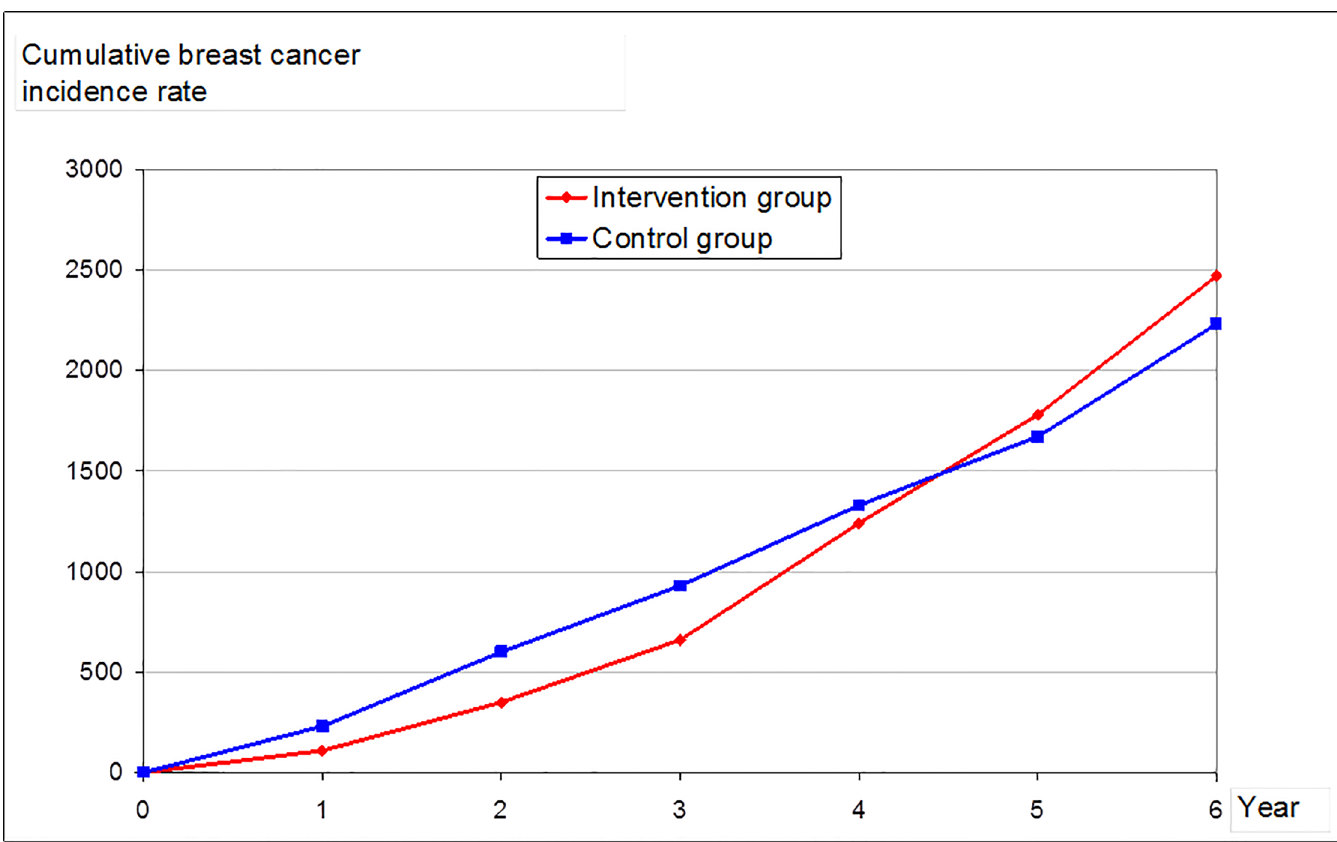
Fig 1. Cumulative breast cancer incidence rates for women in the WHI trial that had not used CHT previous to the randomization.